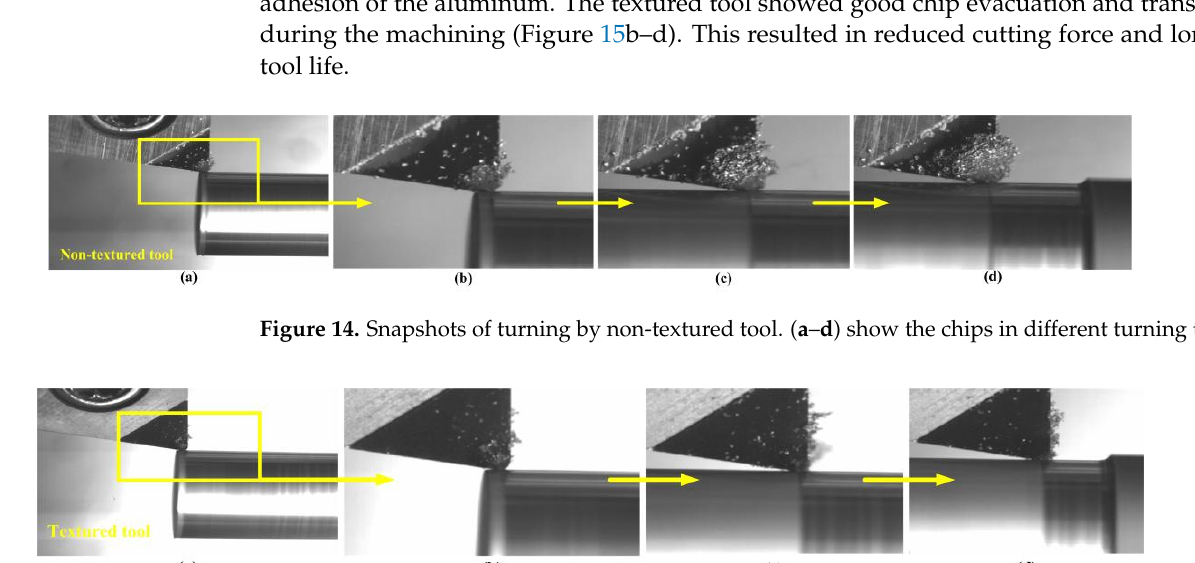
Figure 15. Snapshots of turning by micro-pit-textured tool. ( a – d ) show the chips in different turning time.